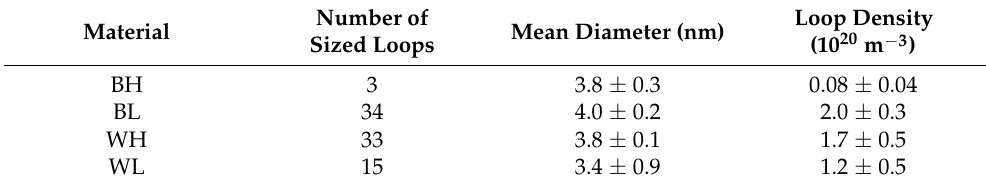
Figure 3. WBDF TEM image for the RPV weld, ( a ) high-flux condition (WH); ( b ) low-flux condition (WL). g = 110. Features identified as dislocation loops are marked with an arrow. Table 4. Estimates of the mean diameter and number density of dislocation